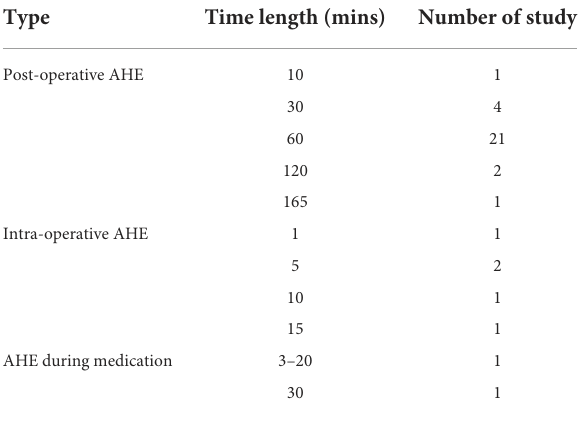
TABLE 2 Summary of the prediction